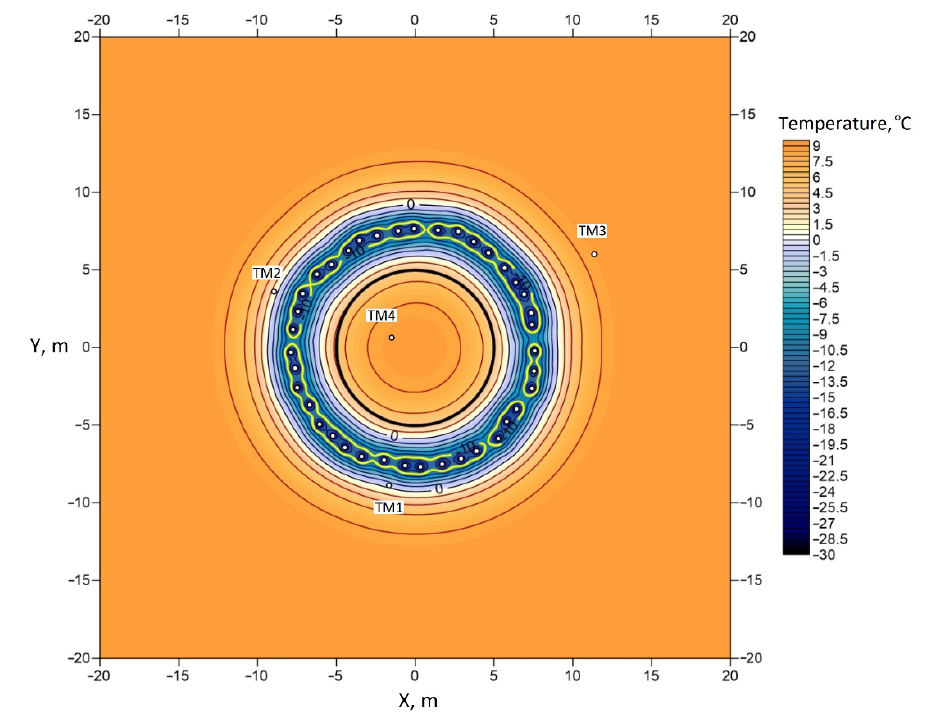
Figure 3. Calculated temperature distribution in the sand layer at a depth of 138